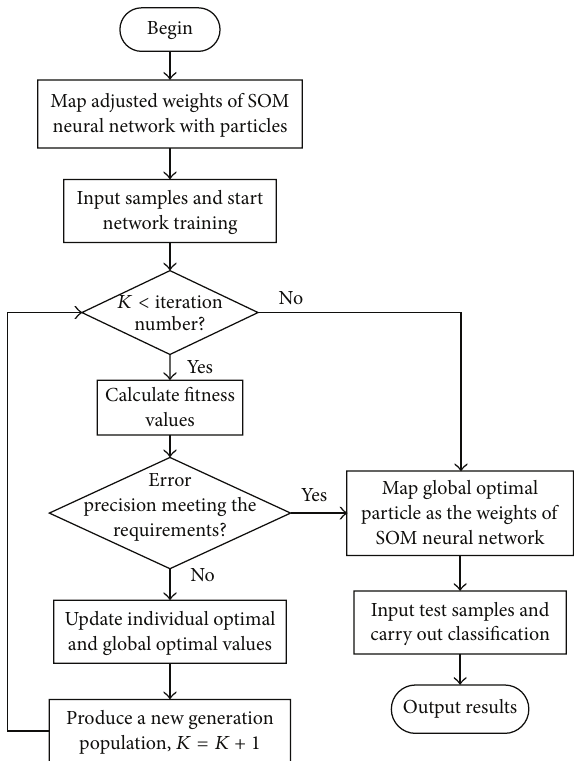
Figure 10: Flowchart of SOM neural network optimized by improved PSO algorithm.